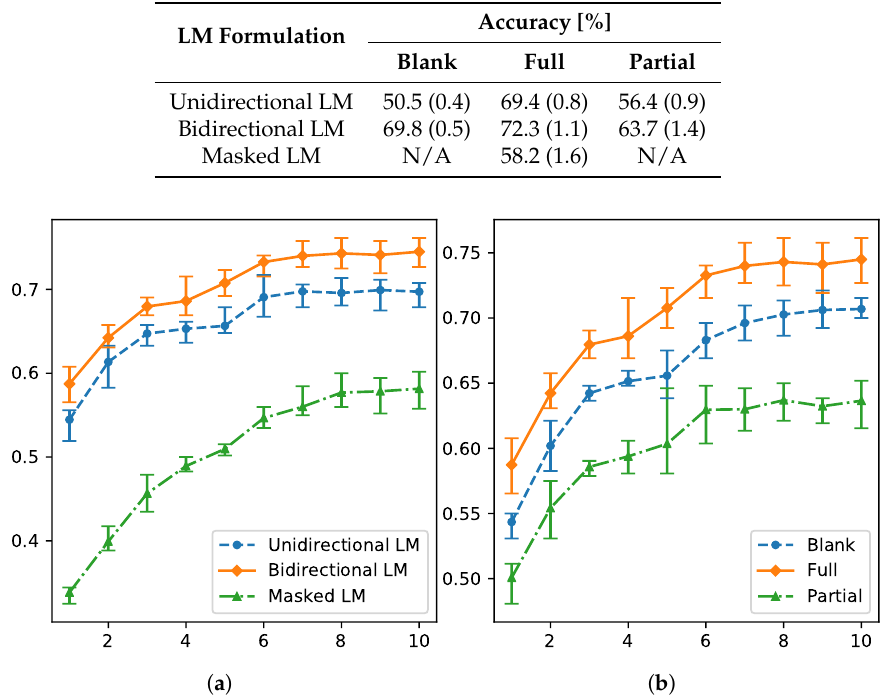
Figure 2. Performance comparison for different LM formulation and scoring strategies: ( a ) the full scoring was applied except for the masked LM; and ( b ) the bidirectional model was used. The x-axis represents the number of epochs and the y-axis represents the validation accuracy for the MSR